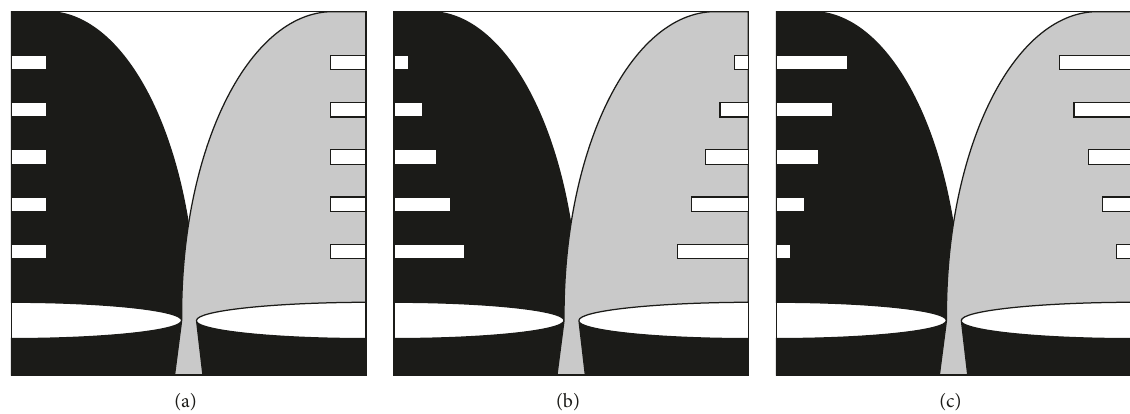
Figure 6: Three different patterns of slots: (a) equal-height slots; (b) the height of the slots decreases linearly along the direction of the antenna opening; (c) the height of the slots increases linearly along the direction of the antenna